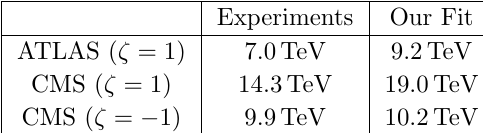
Table 9 . Comparison between the bound on the operator of eq. (C.1) presented by the experi- mental collaborations and the limit extracted with our (cid:12)tting